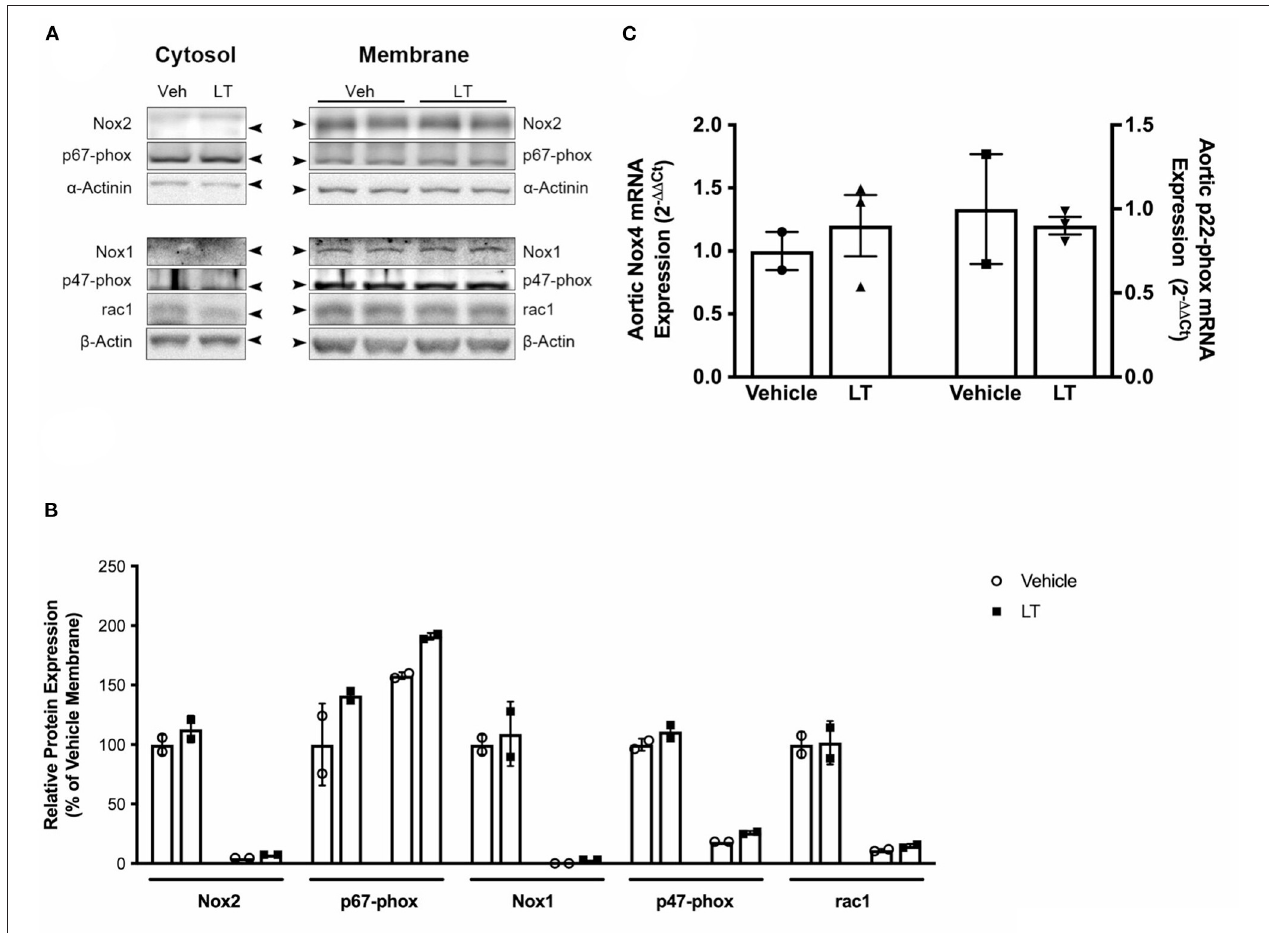
FIGURE 3 | NADPH oxidase subunit expression. (A) Western blot analysis of NADPH oxidase subunit protein expression in cytosolic and membrane fractions of aortic homogenates of cholesterol-fed ApoE − / − mice treated with vehicle or LT. There was no difference in Rac1, Nox1, Nox2, p47-phox, and p67-phox expression. (B) Densitometric quantification of the Western analyses. Expression of genes-of-interest was normalized to housekeeping gene expression. These values were normalized to membrane protein expression of vehicle-treated mice ( n = 2 per group). For each subunit, membrane expression is displayed on the left, cytosolic expression on the right. (C) Real-time PCR analysis of Nox4 and p22-phox subunit mRNA expression in aortic homogenates of cholesterol-fed ApoE − / − mice treated with vehicle or LT. Neither aortic Nox4 nor p22-phox expression was altered by LT treatment in these mice ( n = 2–3 independent measurements (pooled from n=2-3 mice per sample) per